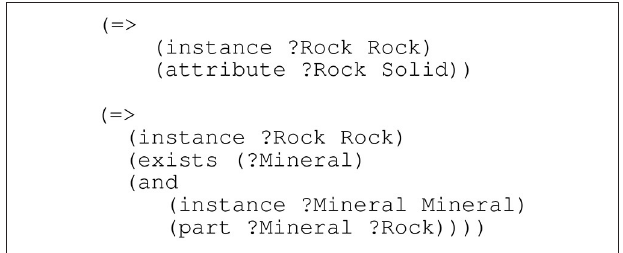
FIGURE 3 | SUMO’s modeling of